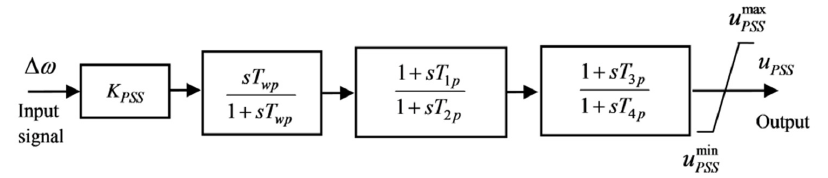
Figure 6. The block diagram of power system stabilizer.